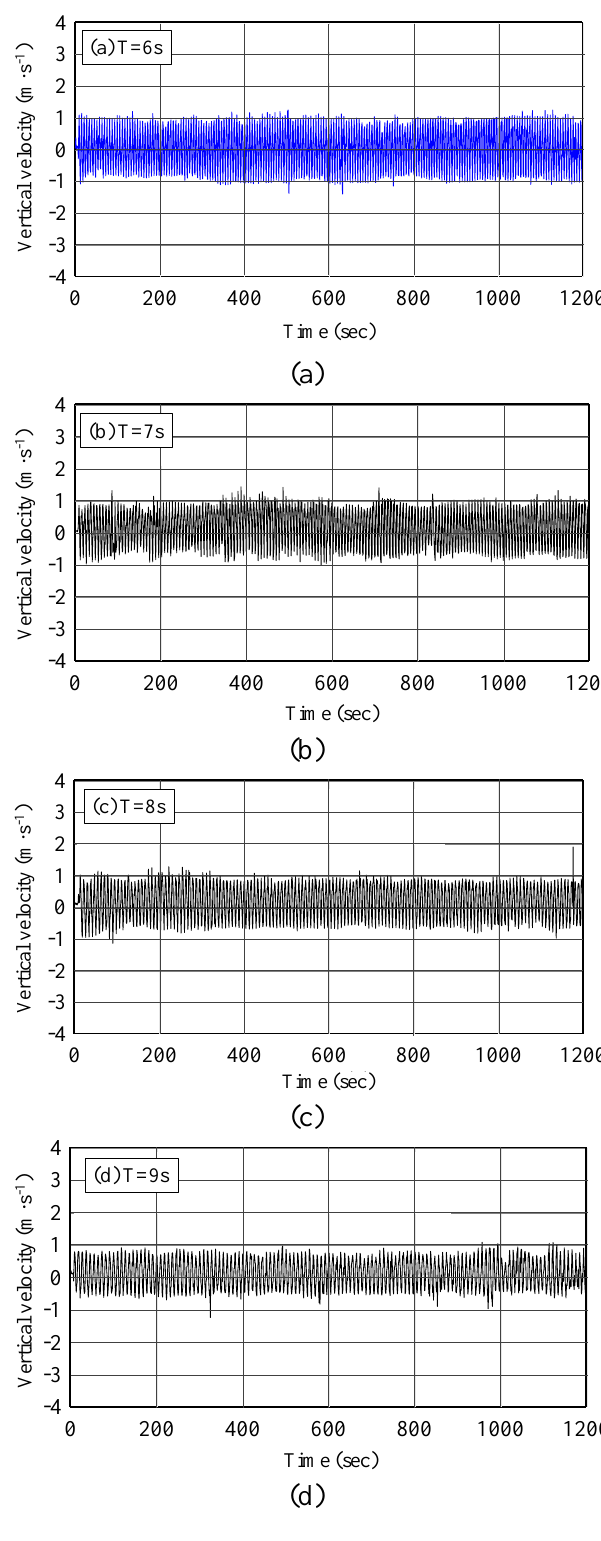
Figure 3. GPS vertical velocity output (a) T = 6 s; (b) T = 7 s; (c) T = 8 s; (d) T = 9